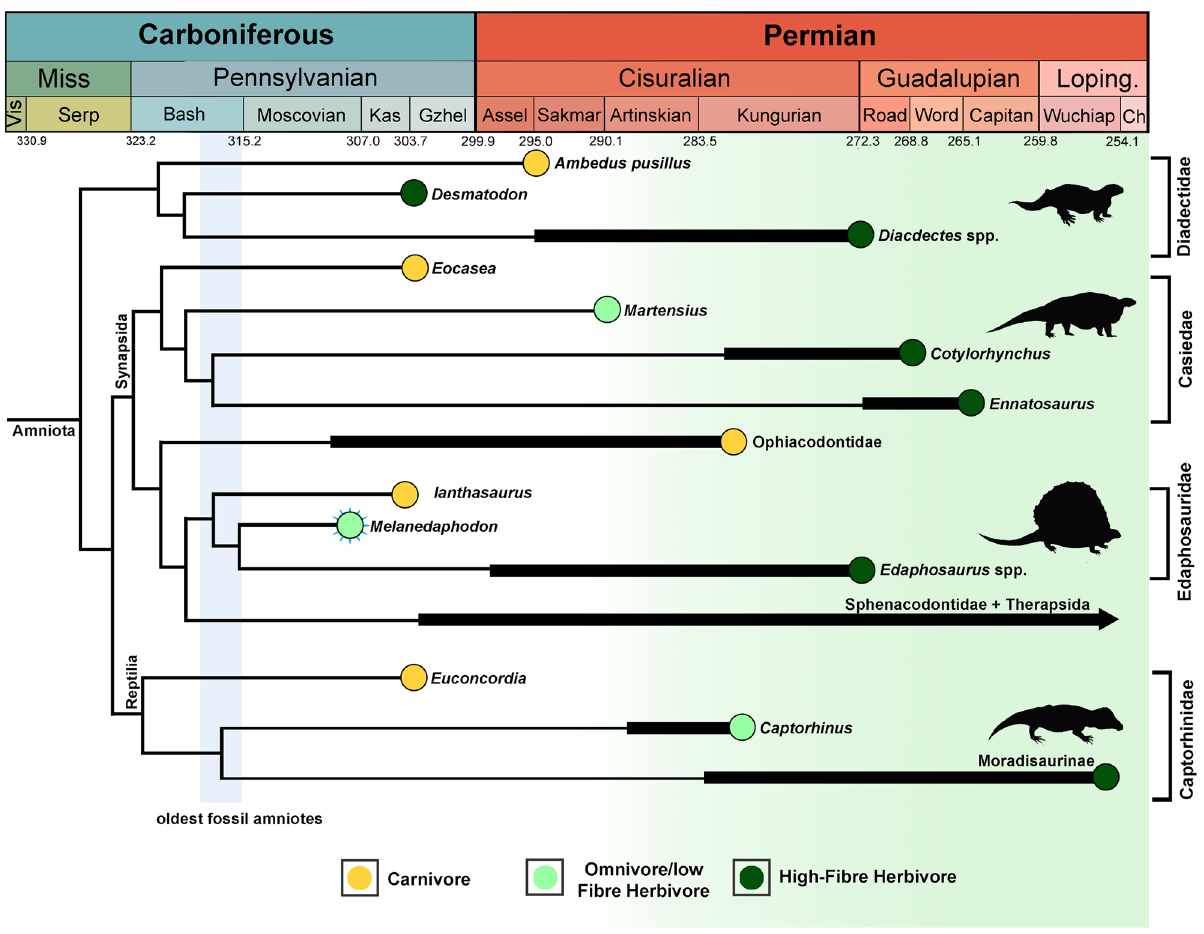
Figure 5. Time-calibrated phylogeny showing the origins of major clades with herbivory across the Permo- Carboniferous. Herbivorous/omnivorous feeding habits among tetrapods are shown to originate in the Late Carboniferous with Melanedaphodon as the oldest known example. However, herbivory becomes more widespread among tetrapods in the Early Permian with a greater volume of high-fibre herbivores. Melanedaphodon is indicated with turquoise sunburst pattern. Dietary inferences are colour-coded (see figure